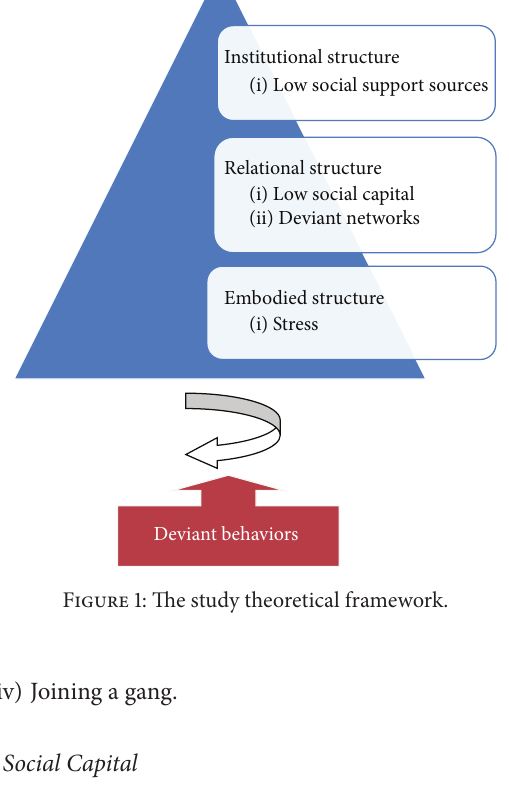
Figure 1: The study theoretical